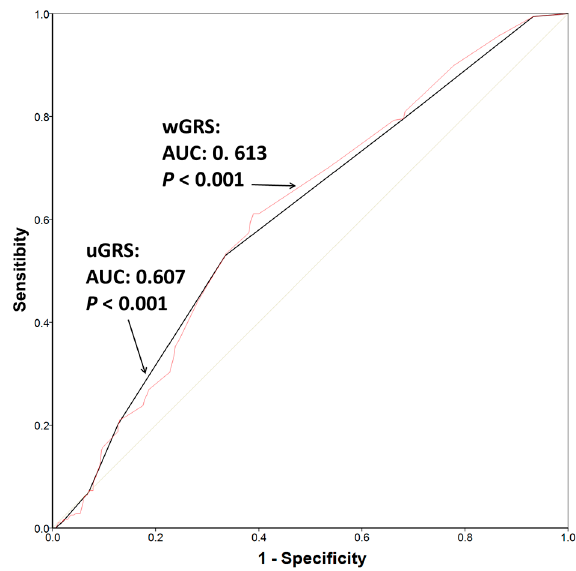
Figure 3. Receiver operating curves (ROCs) of the two (unweighted and weighted) genetic risk scores (GRSs) to predict POAG risk in the 391 cases and 383 controls. Both GRSs included the POAG-SNPs: TMCO1 -rs4656461; CAV1 / CAV2 -rs4236601; CDKN2B-AS1 -rs2157719; and CDKN2A -rs3088440. Area under the curve (AUC) and p -values for the corresponding GRS are shown.